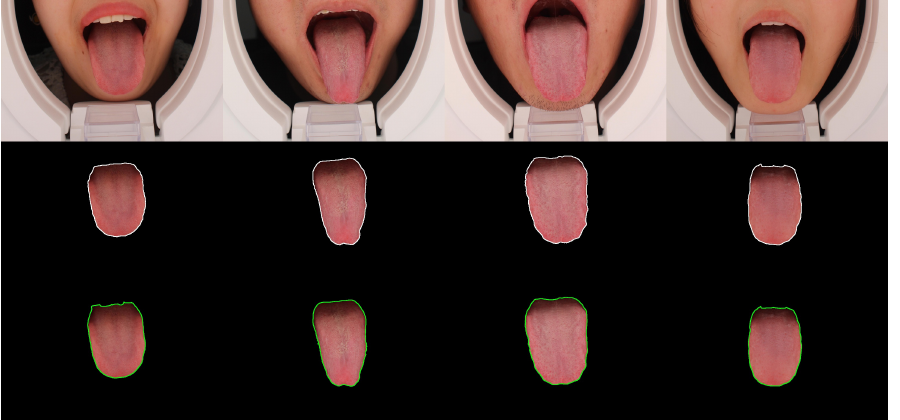
Figure 14. The segmented results for the four tongue images produced by U-Net. The white and green lines indicate the segments labeled by TCM practitioners and the trained